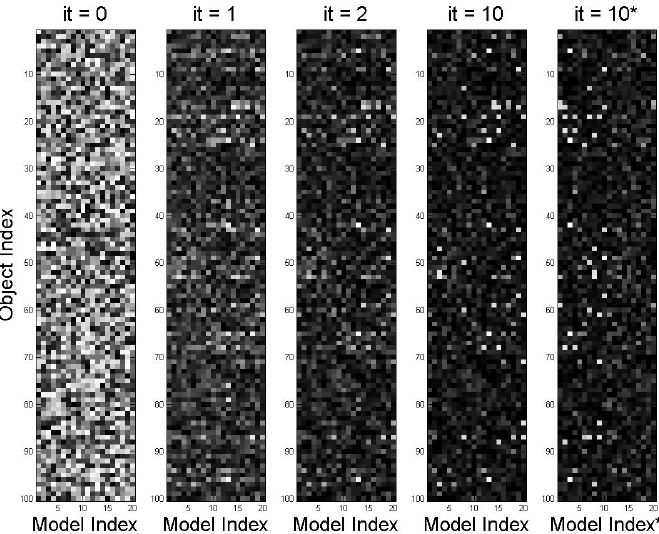
Figure 4. DL situation learning. Situation-model parameters converge close to true values in three